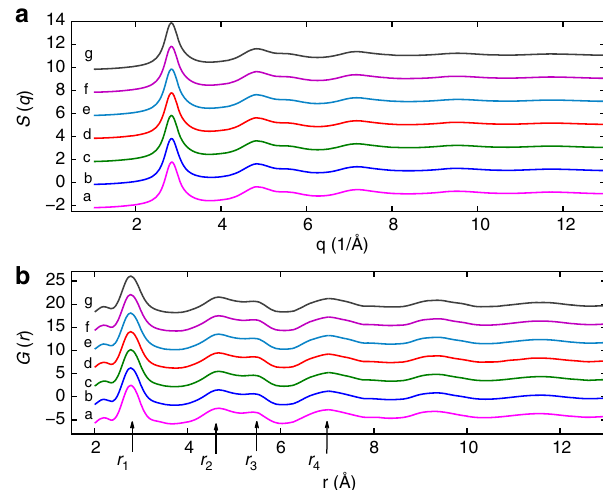
Figure 3 | Structural characterization during aging and thermal treatment. Static structure factor S ( q ) after background subtraction and normalization ( a ), and correlation function G (r) ( b ) are reported as a function of temperature, at the beginning of each isotherm, right after temperature equilibration. Curves labels are for different